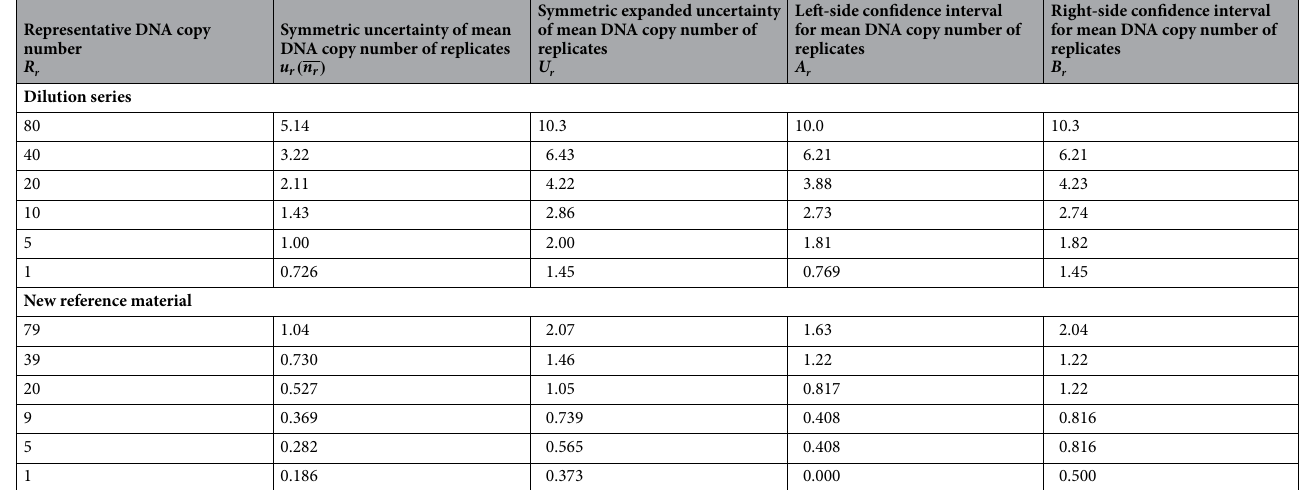
Table 2. Results of measurement uncertainty of